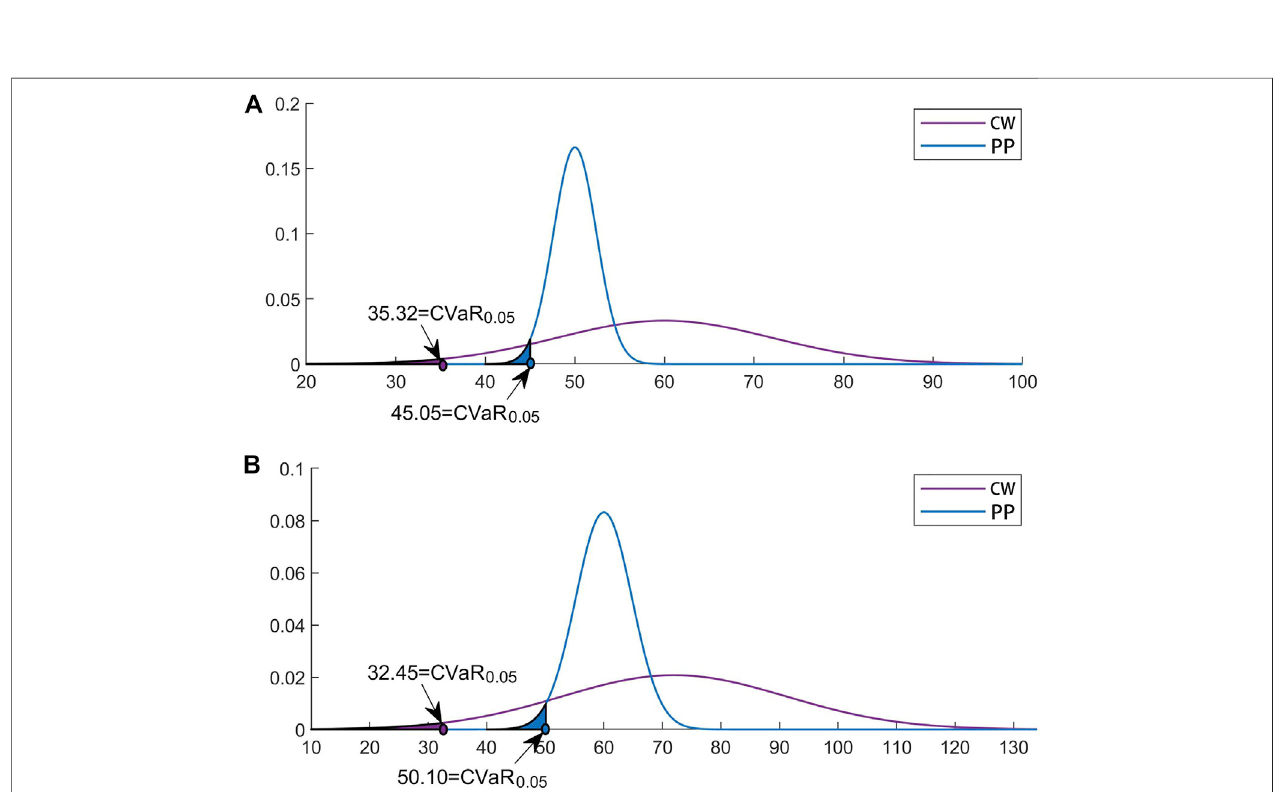
FIGURE 6 | Prior distribution of LIDs with normal distribution in (A) S01 and (B) S02.